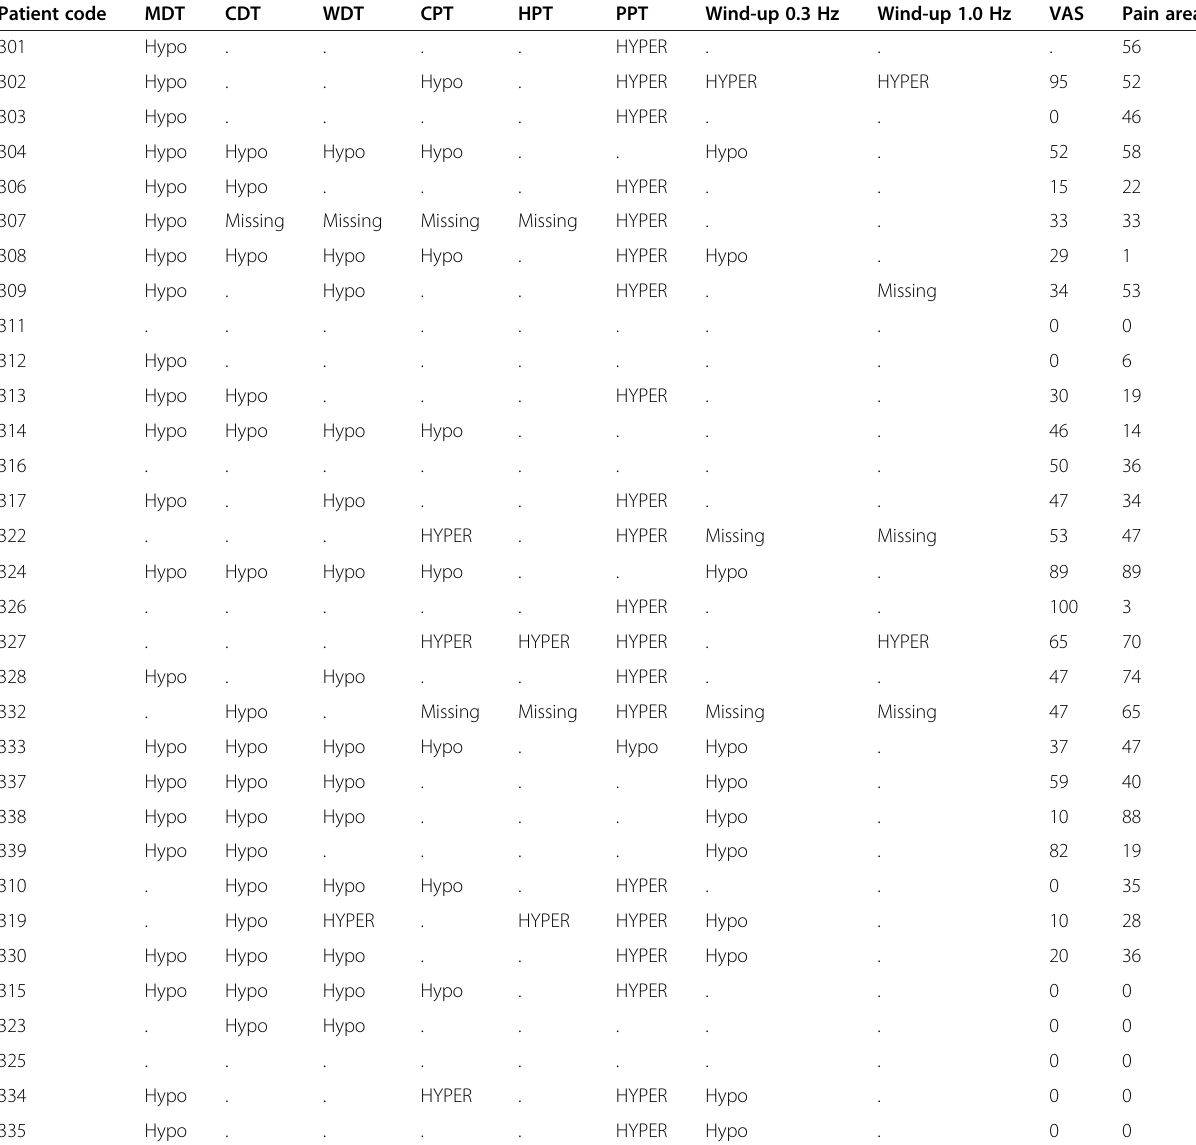
Table 2 Categorized sensory functions from QST data (hypo, normal=blank space, HYPER; see text), current pain intensity and pain area sorted by ‘ pain when walking ’ in the left foot sole of 32 torture victims (see Table